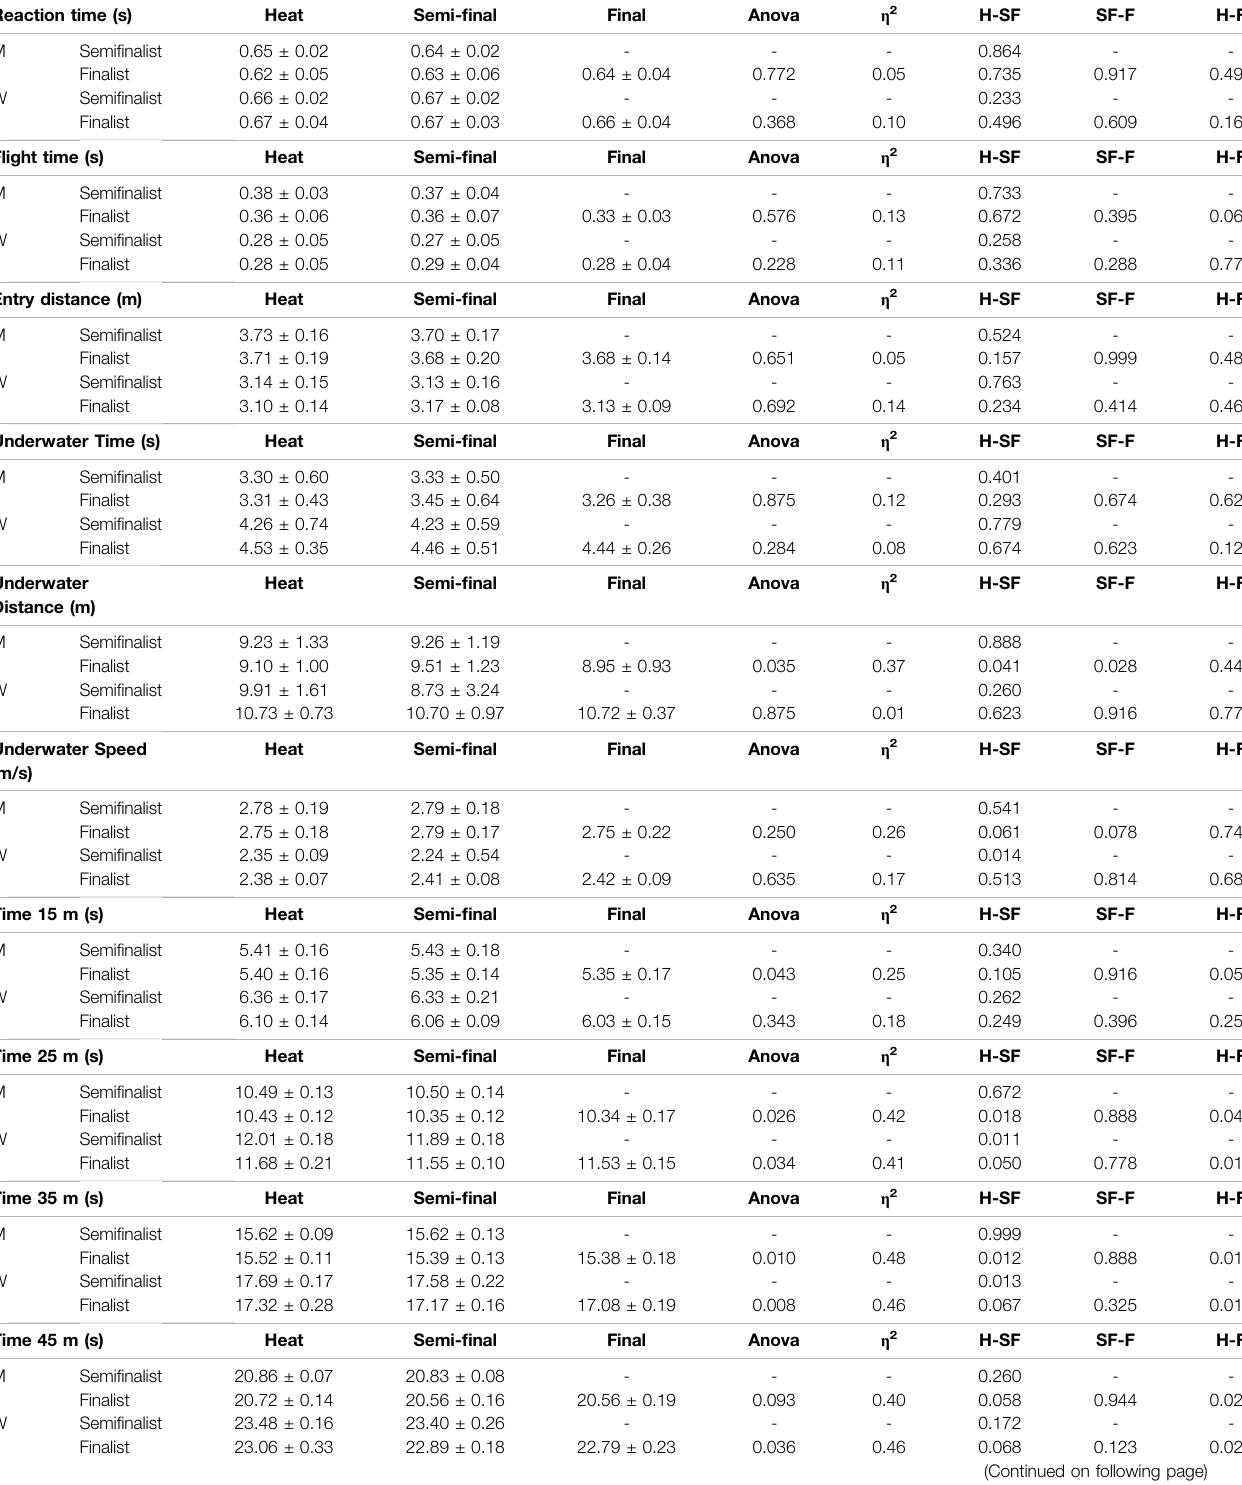
TABLE 4 | Butter fl y performance variables ’ results, p values, and effect sizes ( η 2 ) between the different three rounds. Men (M); Women (W) (LEN European Senior Championships 2021). Reaction time